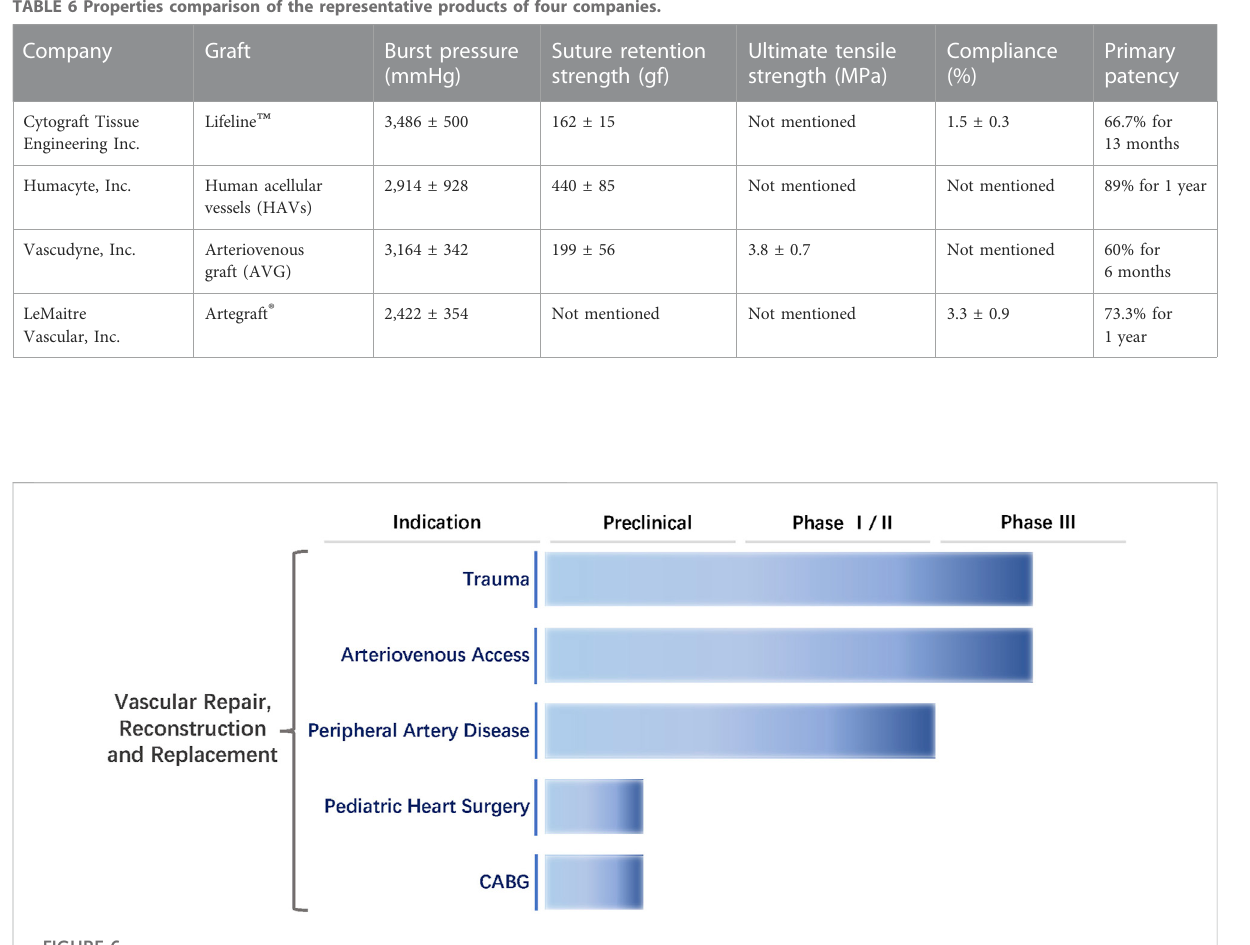
Cytograft Tissue Engineering Inc. Humacyte, Inc.